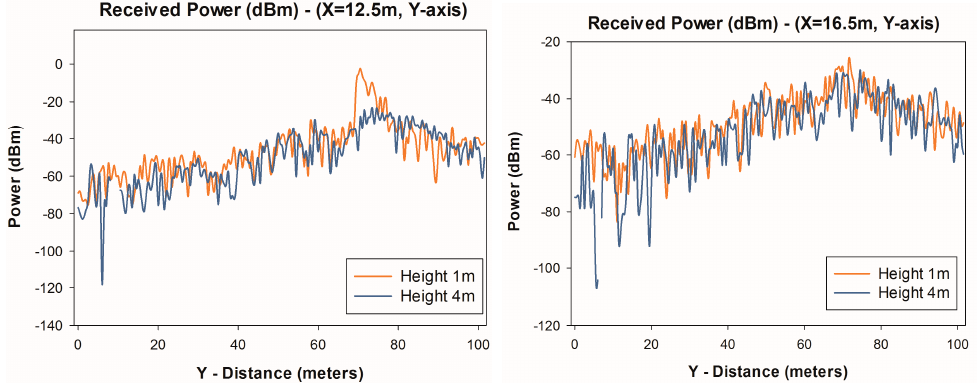
Figure 6. Estimation of radials of received power (dBm) along the Y-axis for X = 12.5m and X = 16.5 m for different